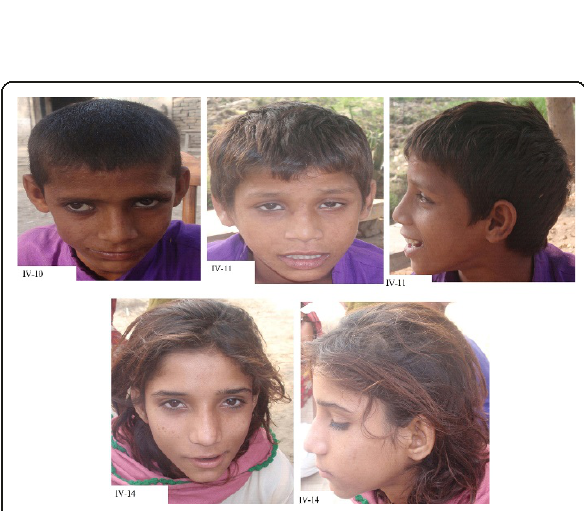
Figure 2 Facial pictures of patients with front and side pose; Individual IV-10 has a minor ophthalmic issue, whereas individuals IV-11, and IV-14 reveal no apparent dysmorphism